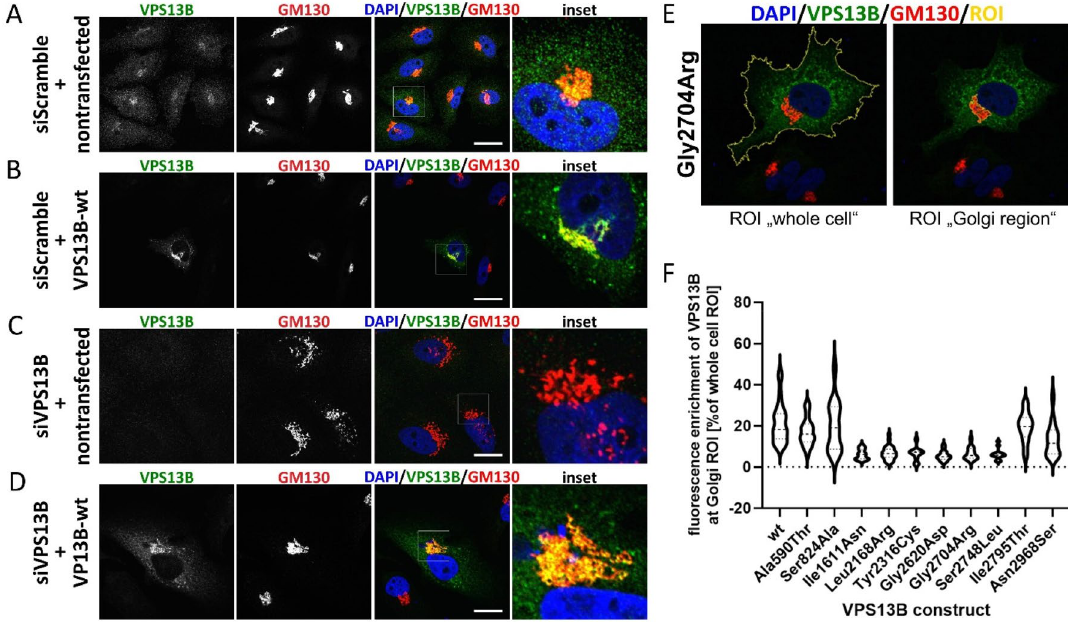
Figure 2. Golgi enrichment is affected by VPS13B missense variants. ( A – D ) Golgi fragmentation is rescued by wild type VPS13B overexpression. HeLa cells were transfected with either control (scrambled siRNA) ( A , B ) or a VPS13B -specific RNAi (siRNA #25721, ambion) ( C , D ). 48 h post RNAi-transfection HeLa cells were processed for overexpression and either nontransfected ( A , C ) or transfected with the pcDNA3.1_VPS13B-wt construct ( B , D ). 24 h later, all cells were processed for immunostaining of VPS13B (green) and GM130 (red). Imaging occurred with confocal microscopy. Nuclei were stained using DAPI, scale bars 10 µm. ( E , F ) Analysis of subcellular localization of cloned VPS13B missense variants. ImageJ analysis was used to evaluate Golgi localization of VPS13B missense variants. Two ROI (yellow) were defined for each cell: “whole cell” ROI was drawn at the outline of the cell to detect total immuofluorescence levels; “Golgi region” was defined by the counterstaining of GM130 (red). Fluorescence intensity of VPS13B (green) in each ROI was measured ( E ). Percentage of VPS13B enrichment at the Golgi was finally calculated for each missense variant using GraphPad prism. We repeated each condition at least 3 times and analyzed each time 3 recordings (with at least 1 transfected cell). Please refer to Supplementary table T3 for statistical information ( F